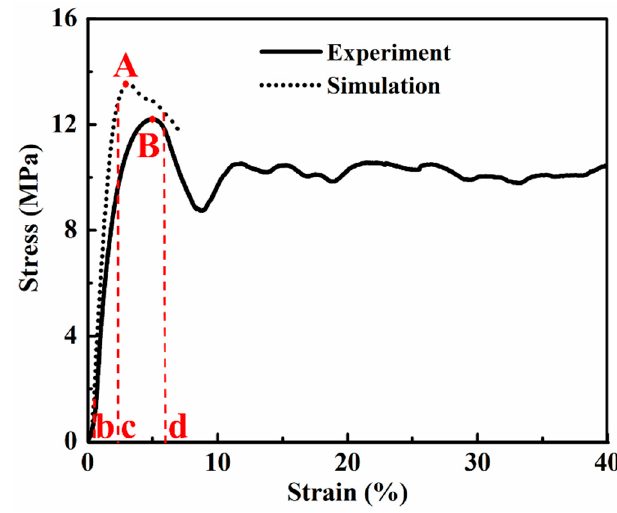
Figure 7. Compressive stress vs strain curves obtained from the experiment and the simulation. In this Figure, point A and point B represent the maximum stress values in experimental results and simulation results respectively, point b, c, and d represent three different strain values (0.2%, 2.8%, and 6%), corresponding to the strain contours in Figure 3b–d.